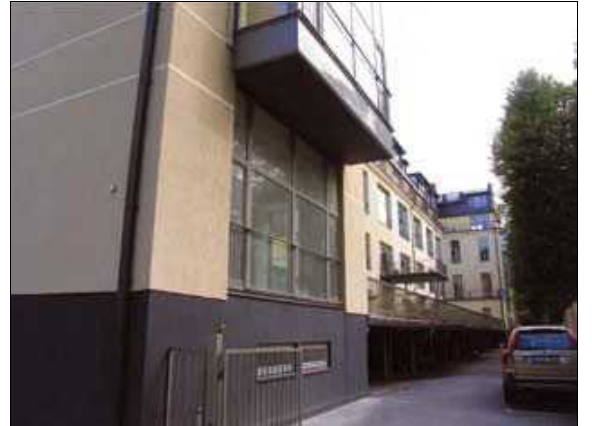
“Sapiegos dominija“ Sapiegos g. Fig. 23. cantonment conversion into block of flats „Sapiegos dominija“ in Sapiega st. e. a­domonis Design Firm